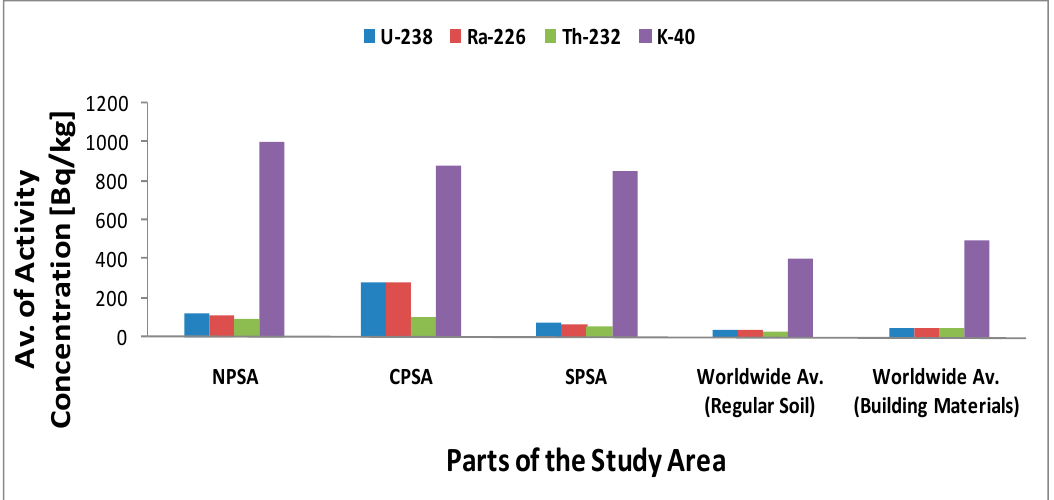
Figure 4. The average activity concentrations of radioisotopes in the three parts of the study area (compared to the worldwide averages).